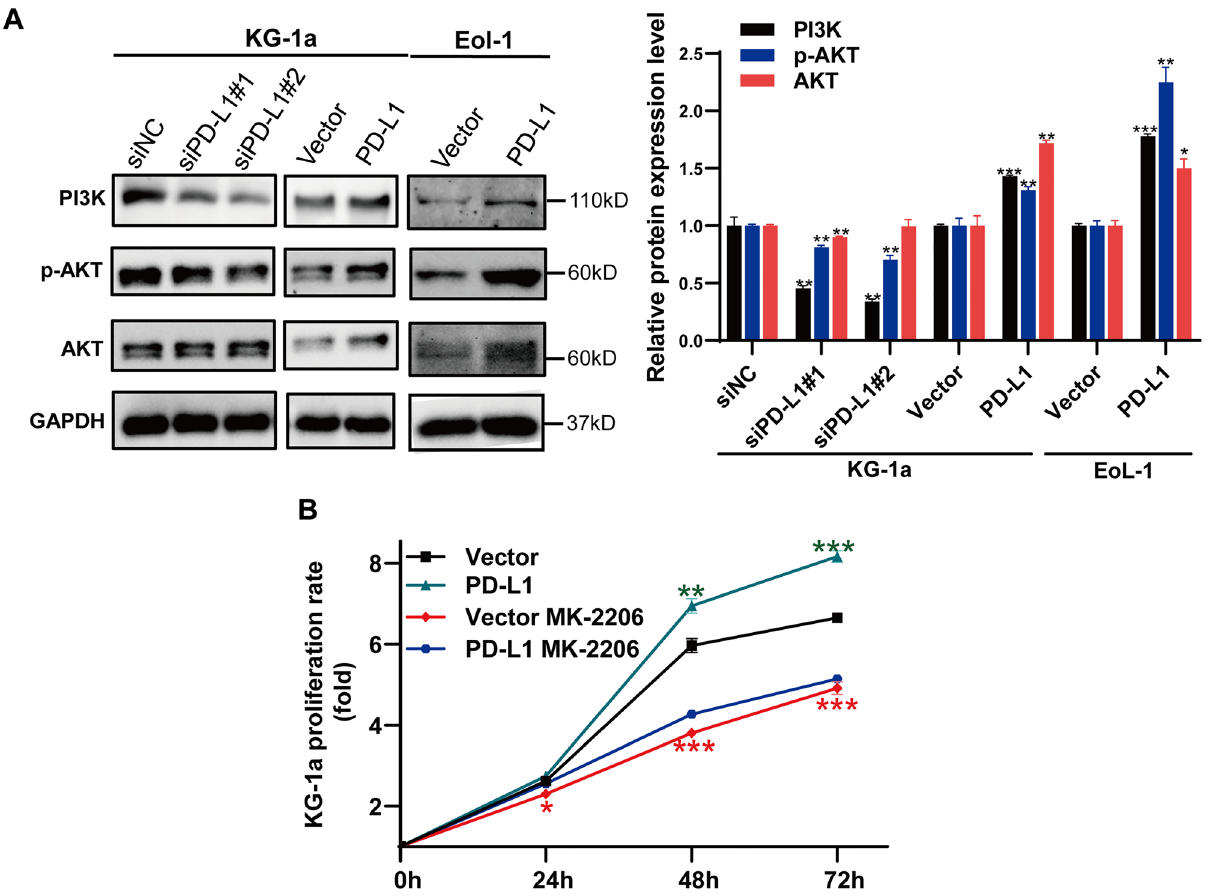
Figure 6. PD-L1 influence AML progression via PI3K-AKT signaling pathway. ( A ) Western blot results showed decreased expression of PI3K, AKT and p-AKT by PD-L1 knockdown in KG-1a cells. Moreover, PD-L1 overexpression induced the expression of PI3K, AKT and p-AKT by in KG-1a and EoL-1 cells. ( B ) The AKT inhibitor MK-2206 (5 μM) had no effect on the proliferation of KG-1a cells upon PD-L1 overexpression. Full- length blots are presented in Supplementary Figure